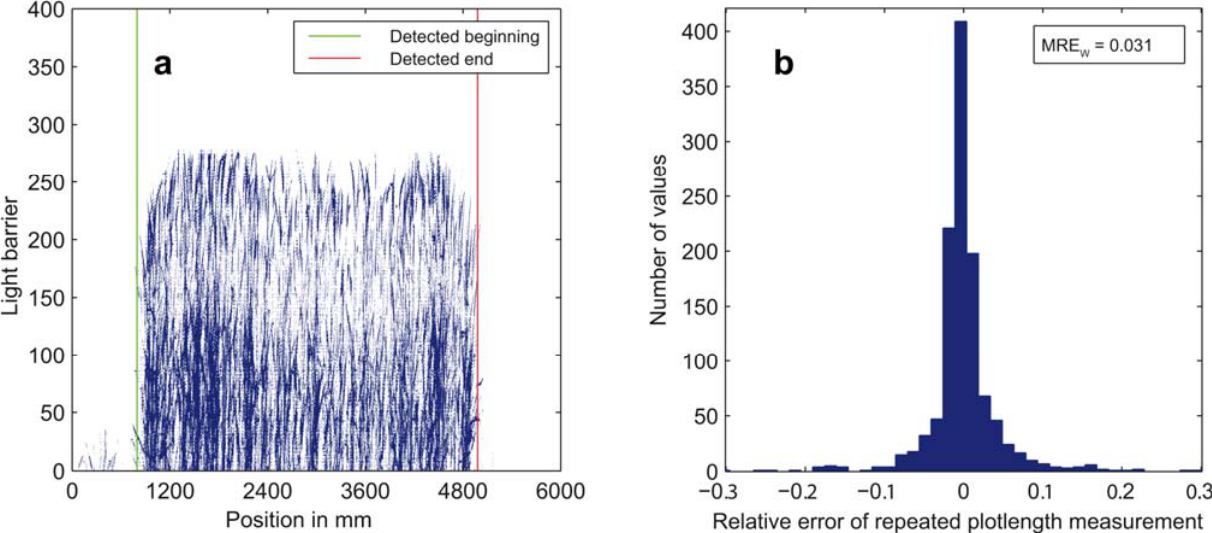
Figure 7. ( a ) Light curtain data with detected start and end of a single plot and ( b ) histogram of relative errors of repeated plot detections during measurements of the years 2011 and 2012 based on two repetitions of 1,200 samples. MRE relative error between repeated plot length